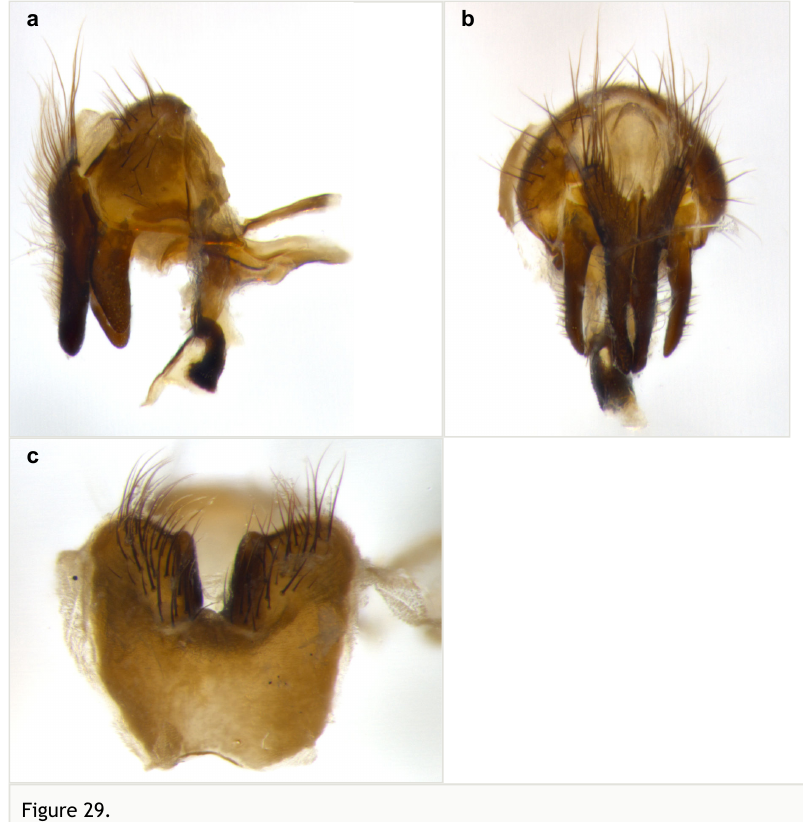
Male terminalia of Calolydella ordinalis sp. n. ; a–c : paratype, voucher n.